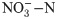

NO3--N and potential mineralizable N (PMN) in bare and cover micro-plots at the studied sampling times following red clover (a and b) and rye (c and d) cover crops.The data shown are the averages from 2011, 2012 and 2013 results. Error bars represent standard errors. The ** and * mark the cases when the differences between cover and bare micro-plots were statistically significant at p<0.05 and p<0.1, respectively.